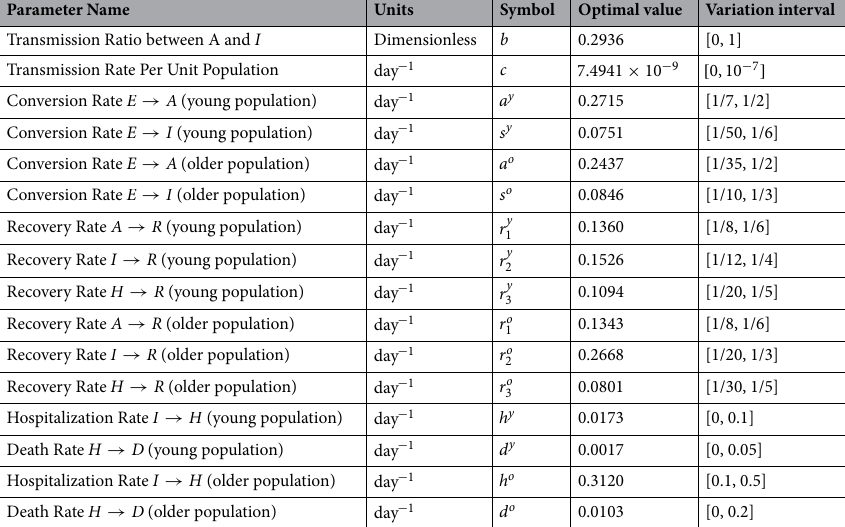
Table 2. Optimized (isotropic) model parameters for the young and older populations, and the variation interval of each parameter within the optimization process (for further details, see “Methods”